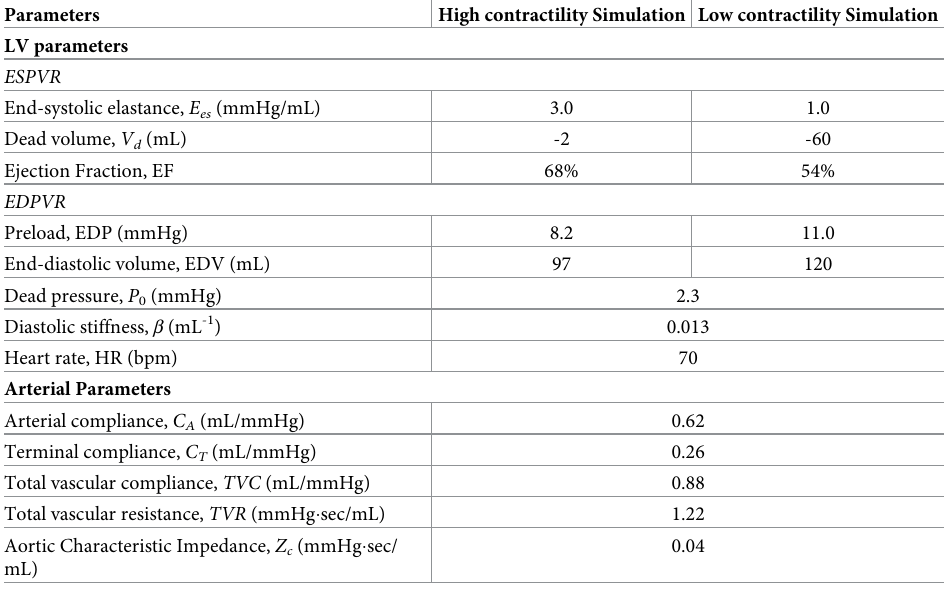
Table 1. Model parameters used to set up the two scenarios of high and low LV contractility.